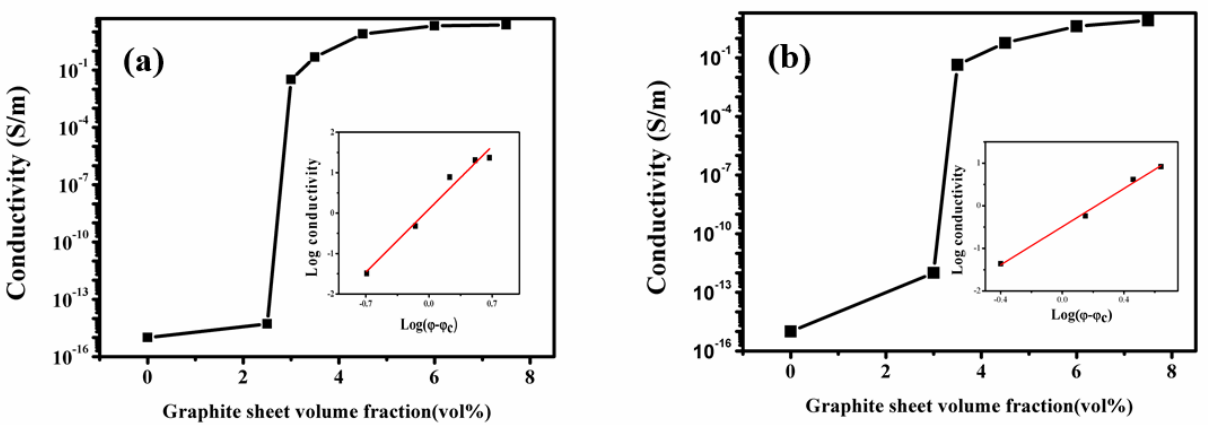
Figure 4. Electrical conductivity of the PA6-GS composites ( a ) and 80PA6/20PA612-GS composites ( b ) as a function of GS content.